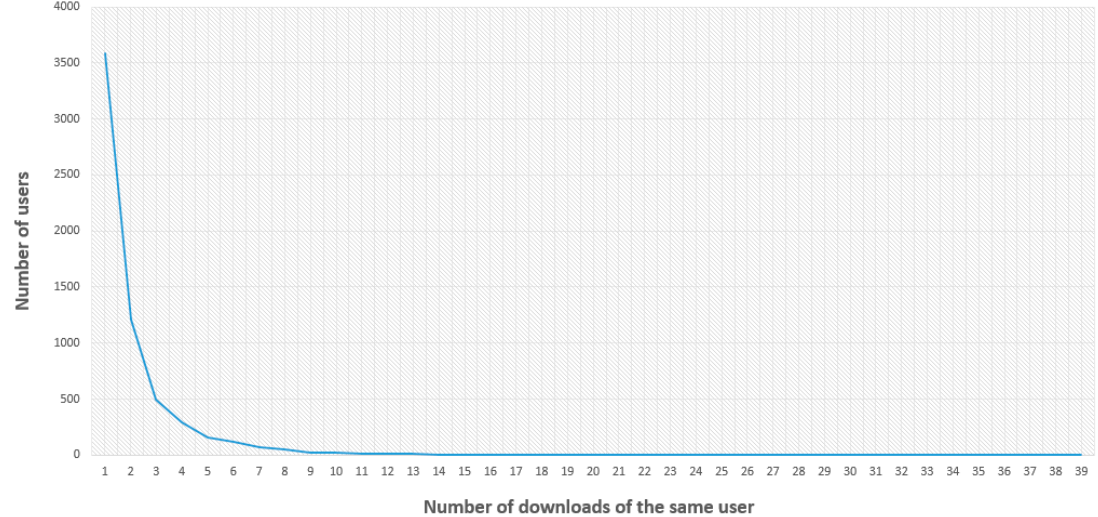
Figure 6. Number of downloads performed by the same user.